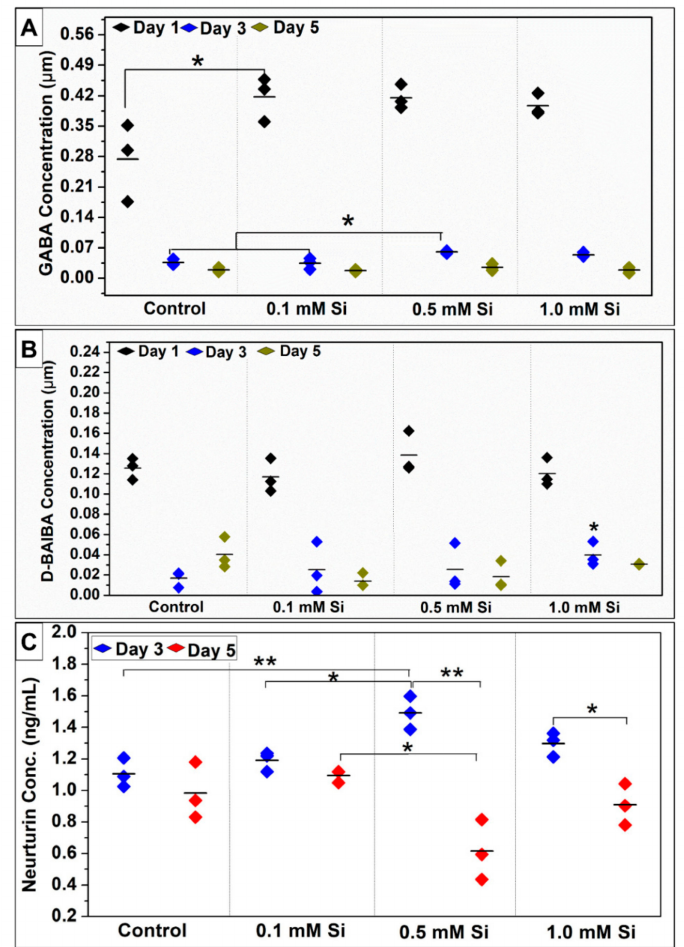
Figure 5. Effect of Silicon-ions on Υ -aminobutyric acid (GABA), D-Beta aminoisobutyric acid (D- BAIBA) concentration in µ M, and Neurturin (ng/mL) expressed by C2C12 during 5 days of differen- tiation. ( A ) GABA concentration increased by adding Si-ions to the differentiation media. ( B ) The concentration of D-BAIBA increased by adding 0.5 mM of Si to the differentiation media at day 1, but no significant difference was observed compared to the control. ( C ) Neurturin expression in media (ng/mL) during C2C12 myoblast cell differentiation for 3 and 5 days. All silicon-ion concen- trations increased the neurturin expression, but the 0.5 mM of silicon-ions significantly increased the neurturin expression compared to the control at day 3 of differentiation (* p < 0.05 and ** p <